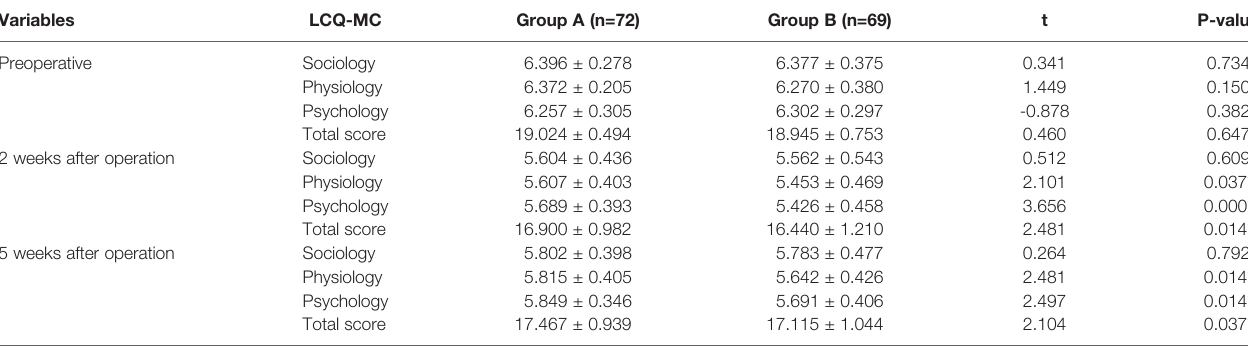
TABLE 4 | Comparison of the mean LCQ-MC score between the two groups before and after surgery.